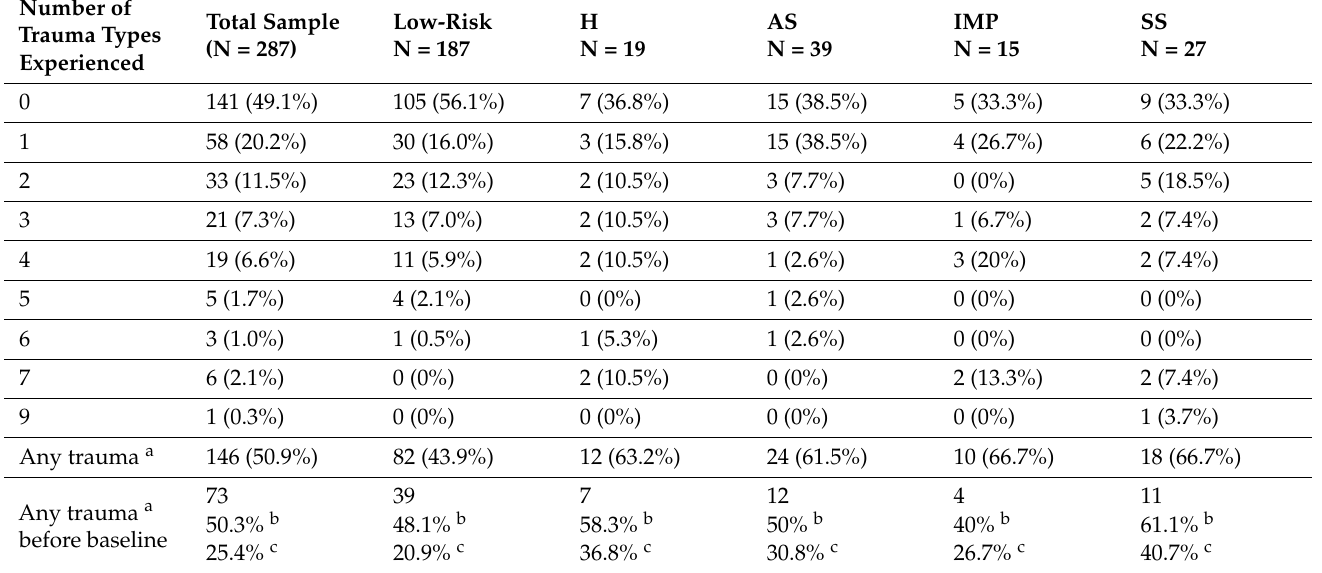
Table 2. Prevalence of traumatic events by